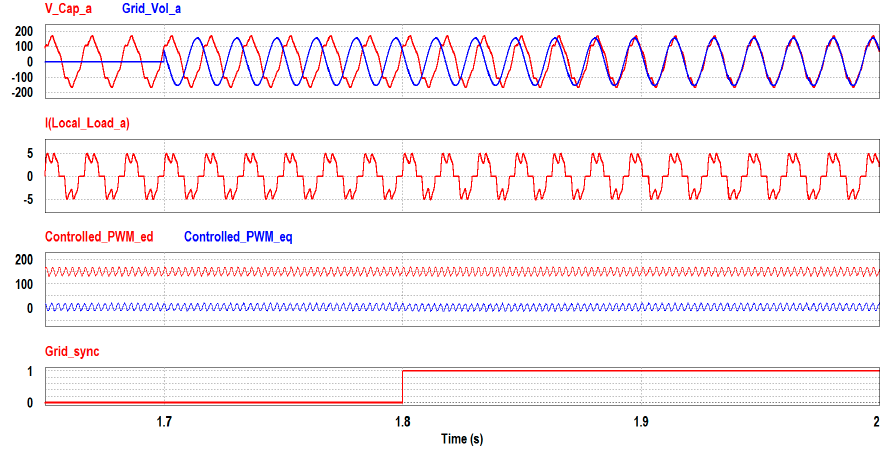
Figure 12. Simulation results in Case II. (SBGS ⟶ GS Mode) (From top to bottom: Measured a phase inverter output voltage and grid voltage, phase local load current, PWM d - q controller outputs, and GS status signal).